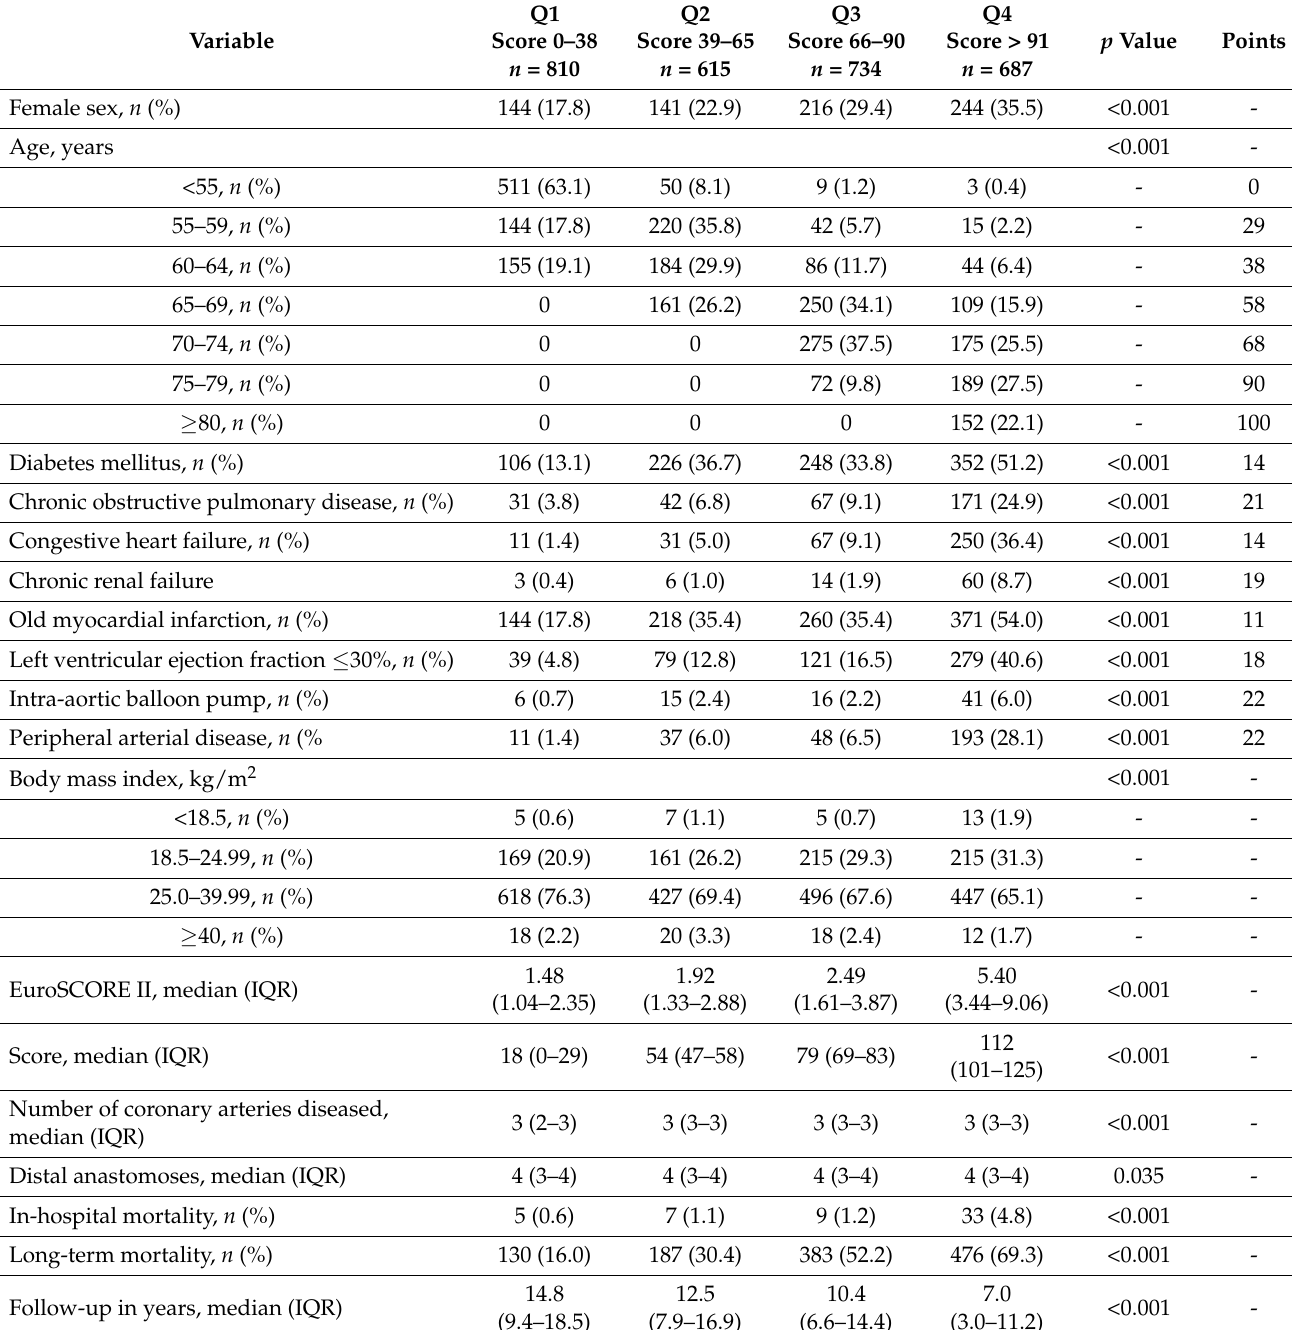
Table 1. Patient characteristics in the quartiles of isolated coronary artery bypass with bilateral internal thoracic artery